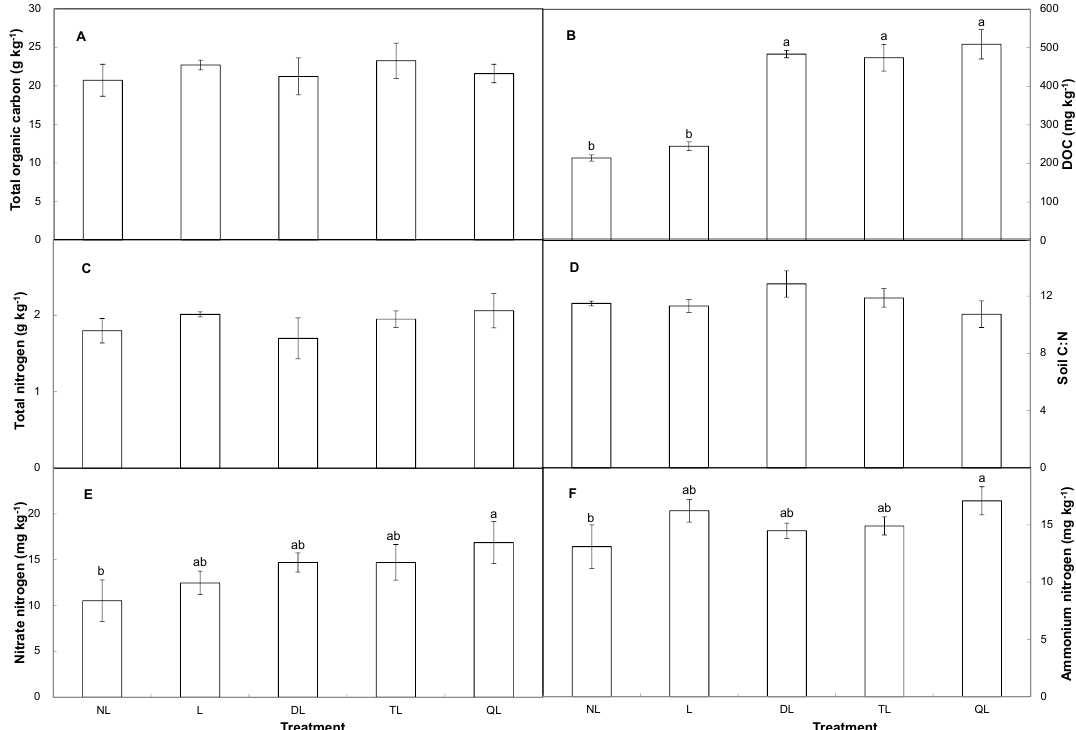
Figure 2. Effects of litter quantity on soil total organic carbon ( A ), dissolved organic carbon (DOC) ( B ), total nitrogen ( C ), the C:N ratio ( D ), nitrate nitrogen ( E ), and ammonium nitrogen ( F ). Different letters indicate significant differences between treatments at p < 0.05. Values are presented as the means ± standard error. See Figure 1 for abbreviations.